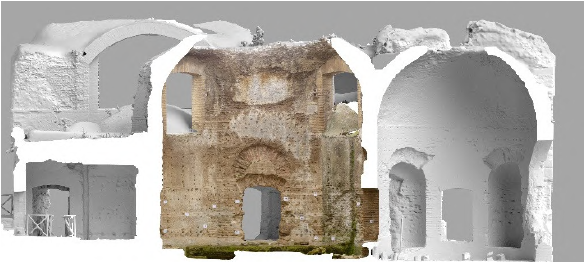
Figure 3. Section of Small Baths in compliance to restorers’ requirements: orthographic views of a mesh model with texture applied on the area of main interest.